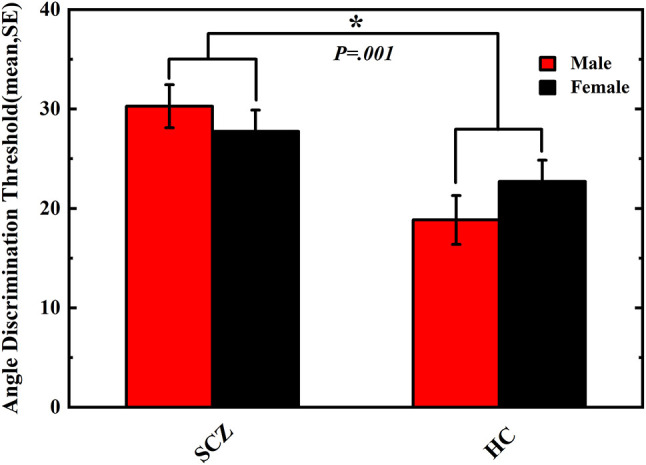
Angle discrimination threshold of schizophrenia patients and healthy controls. Comparison of angle discrimination thresholds in male and female participants between schizophrenia and healthy control. Vertical error bar represents standard error of the mean. Asterisk means P < 0.05.The difference of tactile angle discrimination threshold between SCZ group and HC group was significant (P = 0.001).